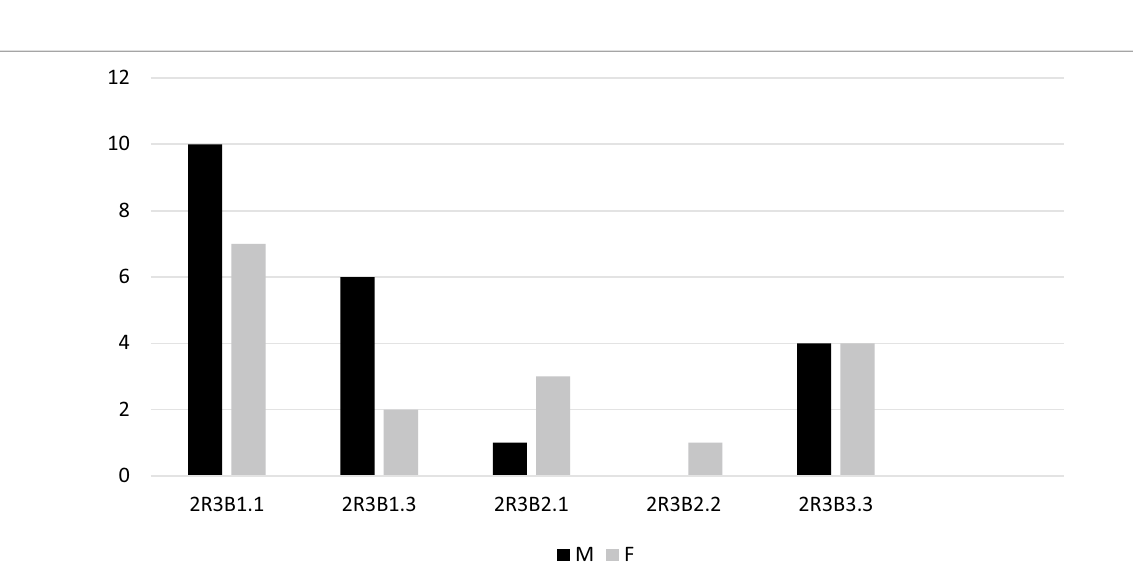
Fig. 7 Distribution of partial-articular patterns of DRFs according to gender. M, male; F, female. DRFs, distal radius